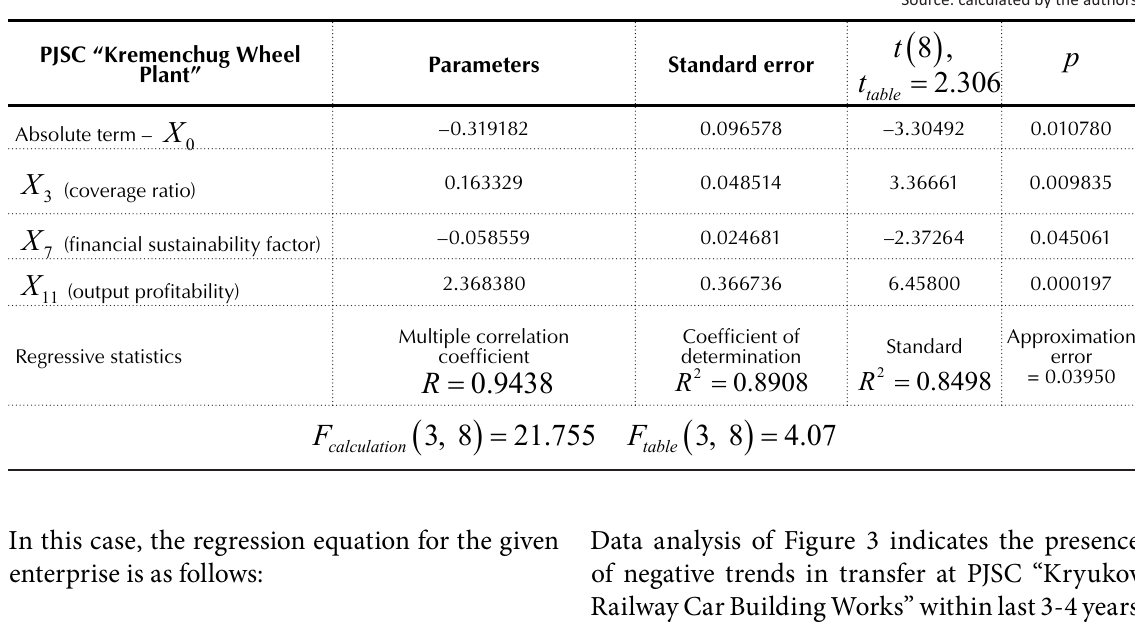
Table 3. Correlation and regression model of the internal capacity of technology transfer system development at PJSC “Kremenchug Wheel Plant”